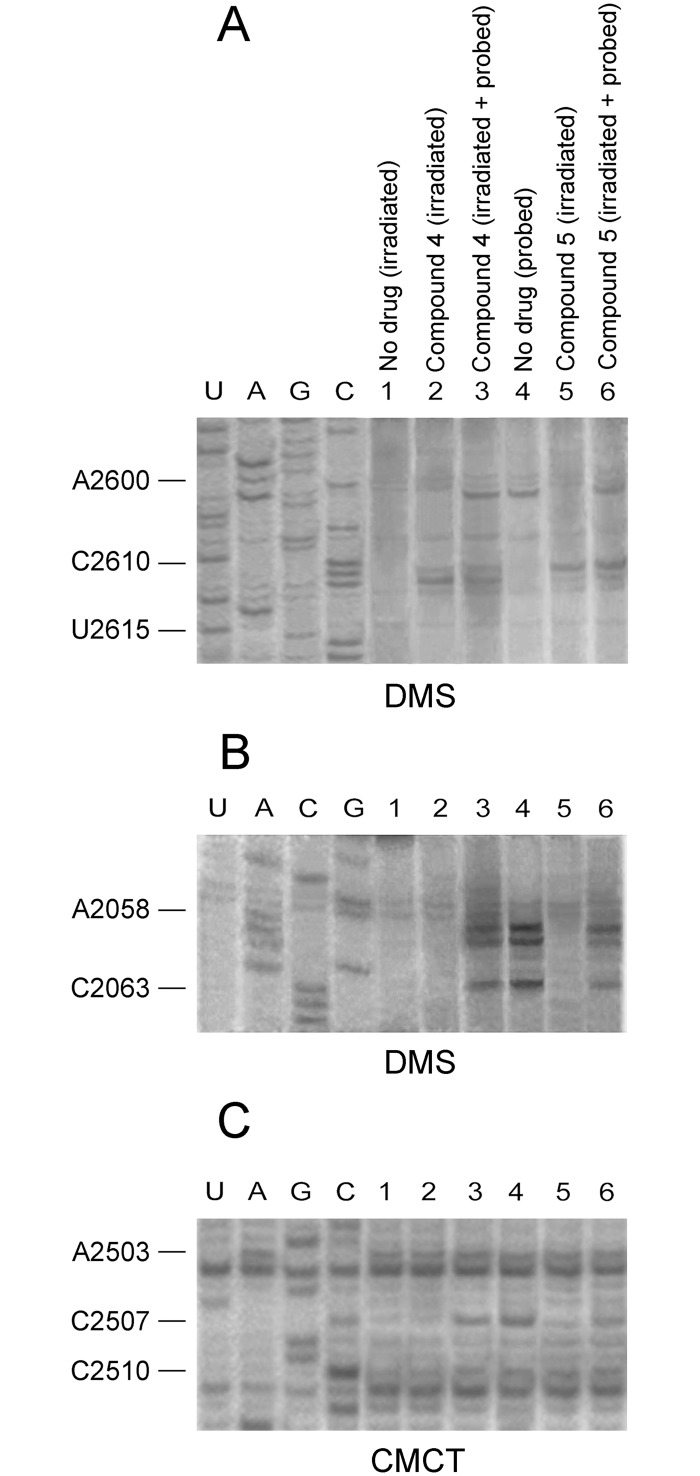
CAM dimer crosslinking at the entrance to the exit tunnel, upon UV-irradiation.Ribosomes from E. coli were irradiated with 365 nm light for 30 min (panels A-C), in the absence (lane 1) or the presence of compound 4 (lanes 2 and 3) or compound 5 (lanes 5 and 6). The irradiation products were analyzed by probing with DMS (panels A and B) or CMCT (panel C) and primer extension, before (lanes 3 and 6) or after discharging from excess CAM dimer (lanes 2 and 5). Probing and primer extension analysis were also applied to non-treated ribosomes (lane 4). Numbering of nucleosides for the sequencing lanes is indicated at the left. (A) Analysis of the A2600-U2615 region of 23S rRNA. (B) Analysis of the C2055-A2065 region (entrance to the exit tunnel) of 23S rRNA. (C) Analysis of the A2500-U2506 region (PTase catalytic center) of 23S rRNA.